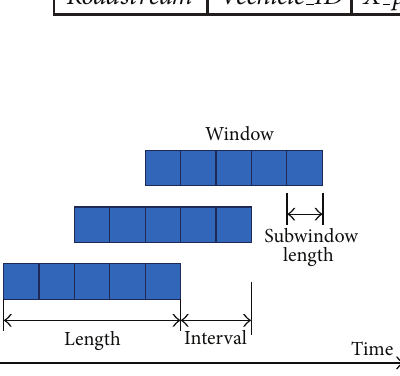
Figure 5: Sliding windows and Subwindows.